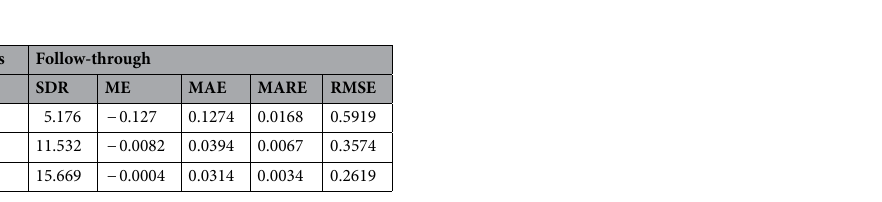
Table 5. Evaluation indexes of three types of driver following behavior models corresponding to ECE working conditions.